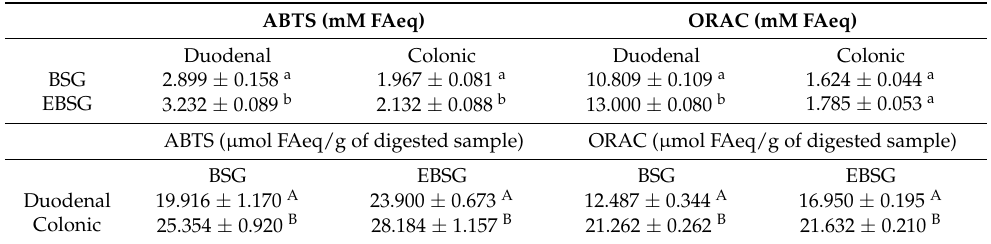
Table 7. Antioxidant capacity for BSG and EBSG intestinal and colonic fermented digests. ABTS (mM FAeq) ORAC (mM FAeq) Duodenal Colonic Duodenal